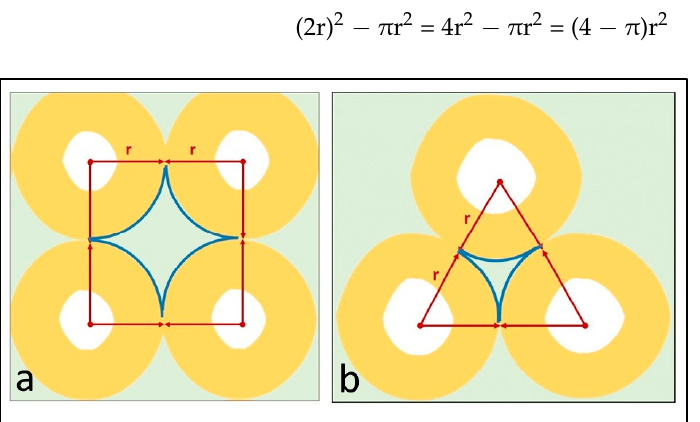
Figure 3. Schematic representations of the interosteonal area surrounded by the neighboring osteons in the H 2 subtype ( a ) and H 3 subtype ( b ) of dense Haversian tissue for its theoretical calculation. In the H 3 subtype, the interosteonal area can be considered as the difference between the equilateral triangle drawn on the central point of the Haversian canal of three adjacent osteons and the area occupied by three cloves of a sixth of an osteon (Figure 3b). Firstly, the formula to determine the area of an equilateral triangle knowing Side l (that is 2r) can be applied: